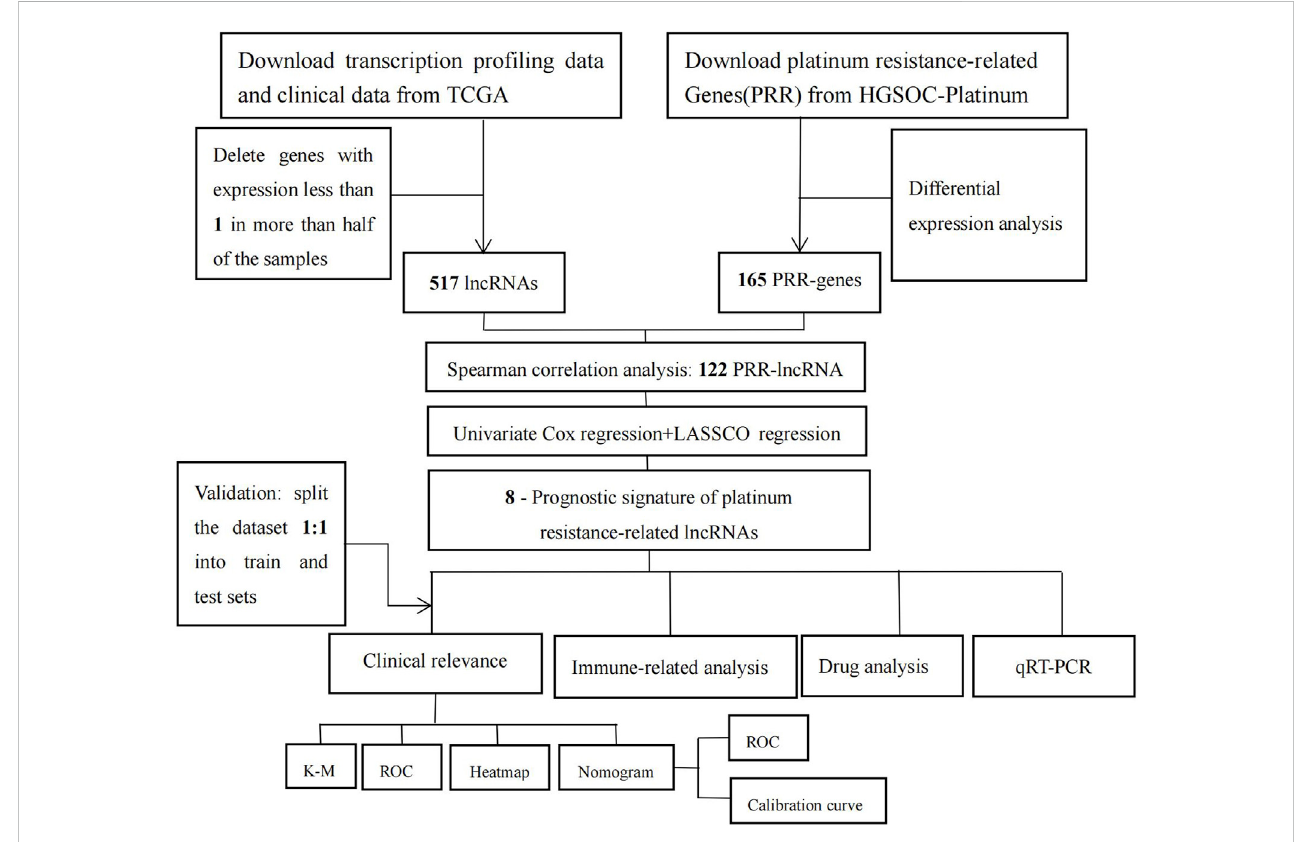
FIGURE 1 Flow-process diagram of the